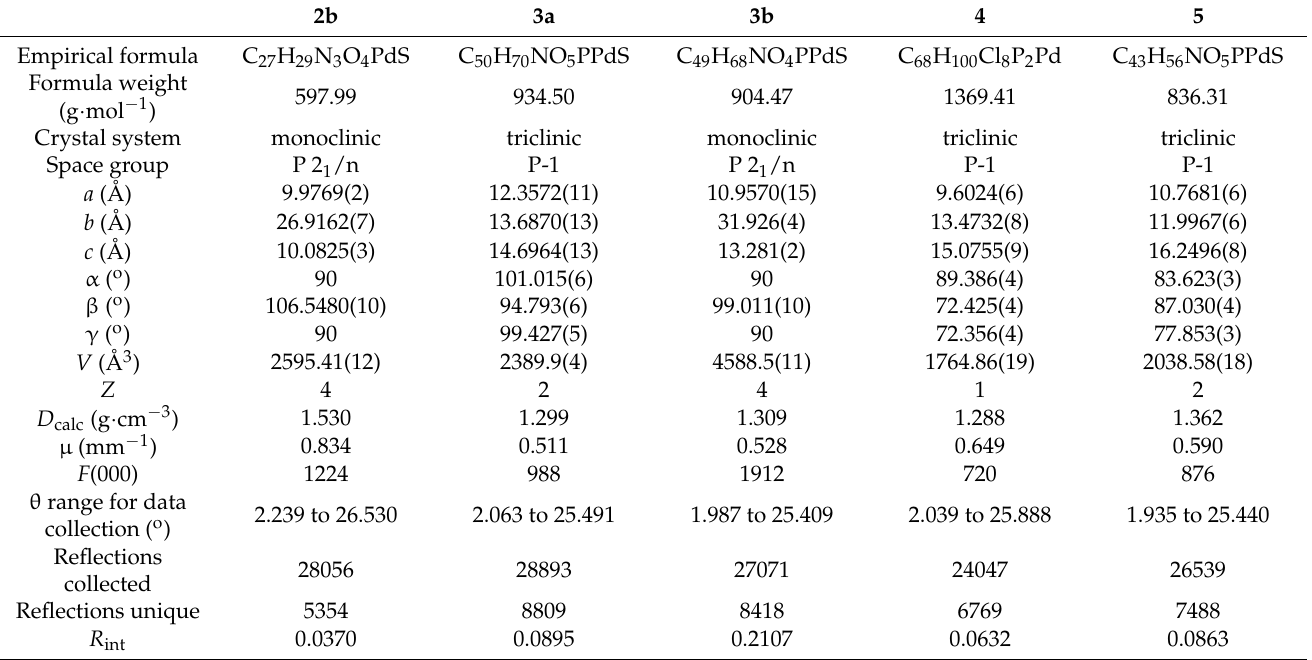
Table 6. Crystallographic data and structure refinement parameters for 1 – 4